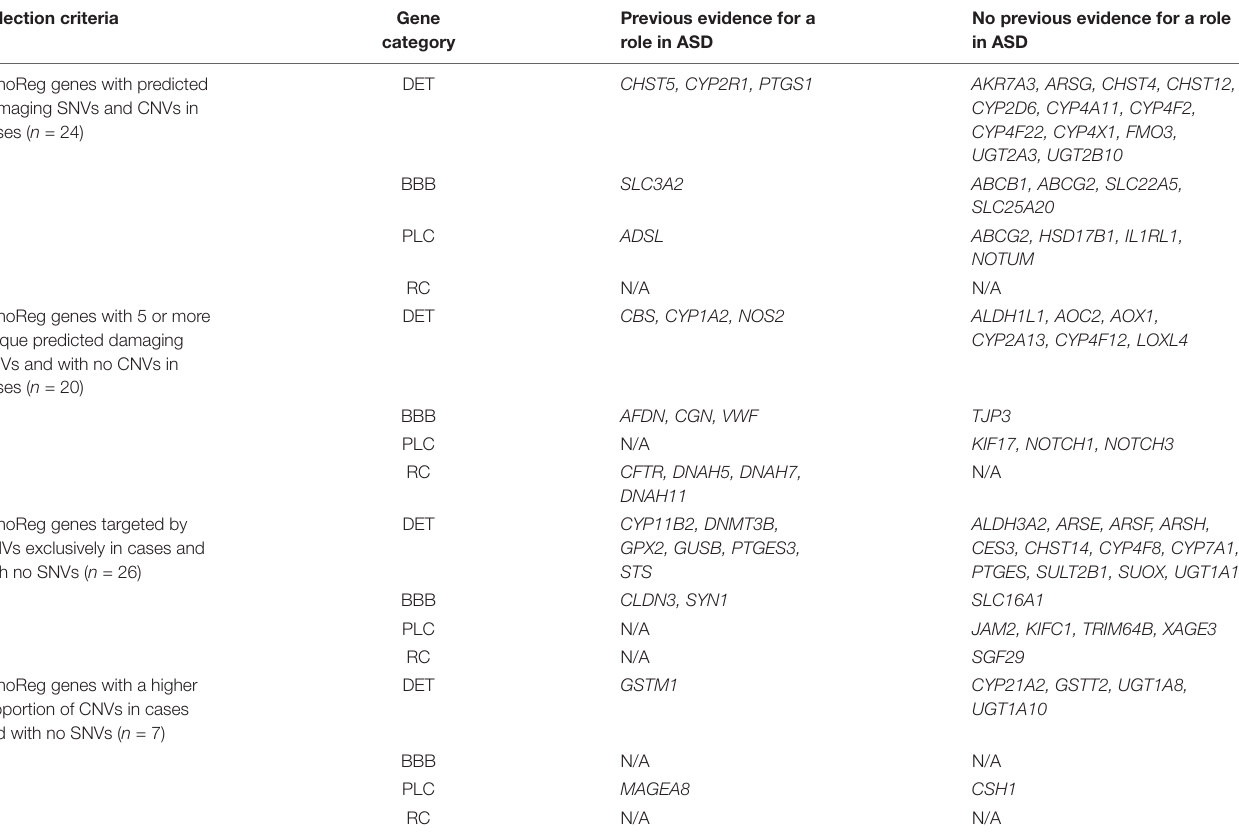
TABLE 4 | XenoReg genes with a high evidence for a role in ASD. Selection criteria Gene